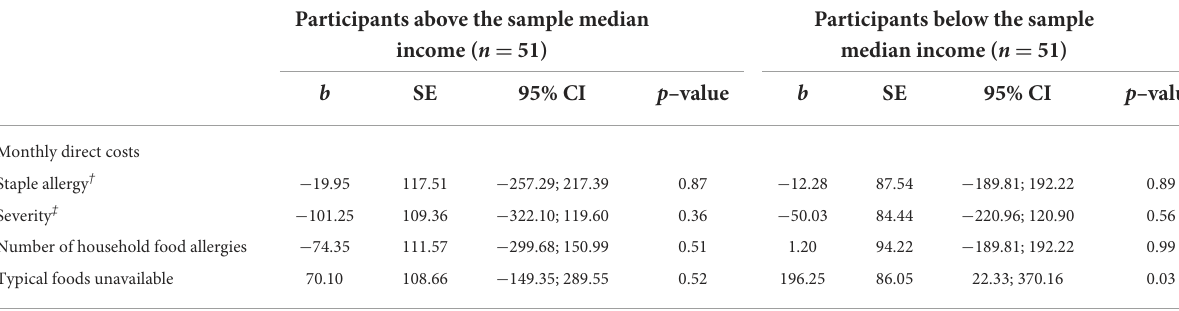
TABLE 2 Predictors of monthly direct grocery costs among higher and lower income households with food allergy. Participants above the sample